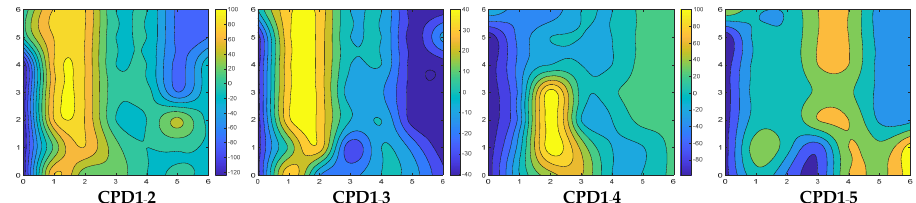
Figure 1. Spatial distribution of PL carrier phase data.